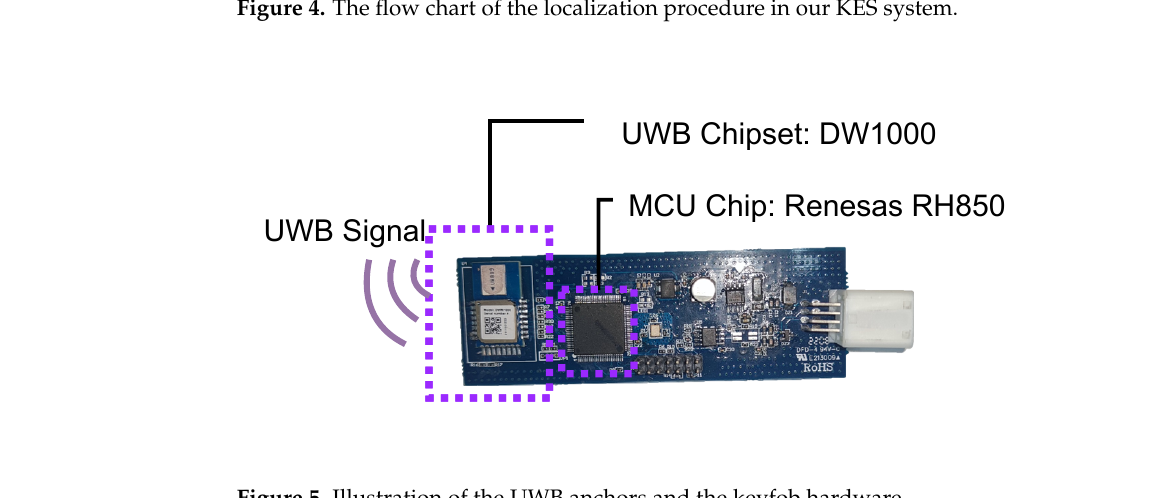
Figure 5. Illustration of the UWB anchors and the keyfob